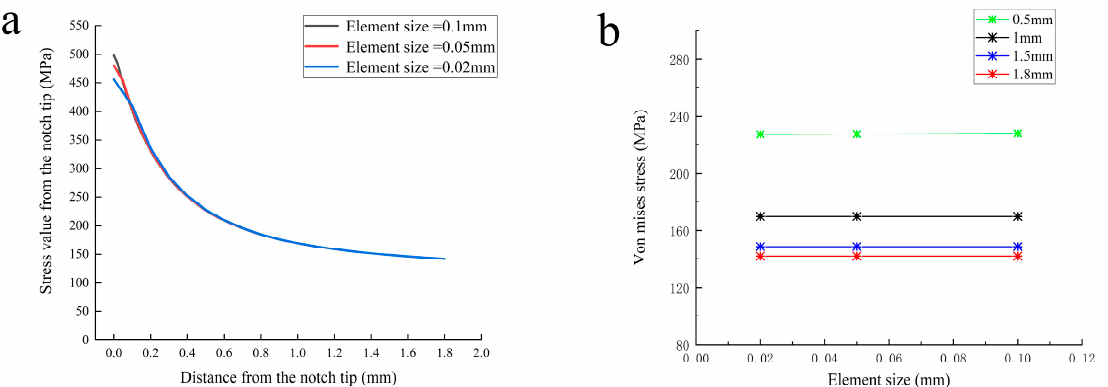
Figure 7. Finite element meshing, loading and constraining methods of notched specimens.